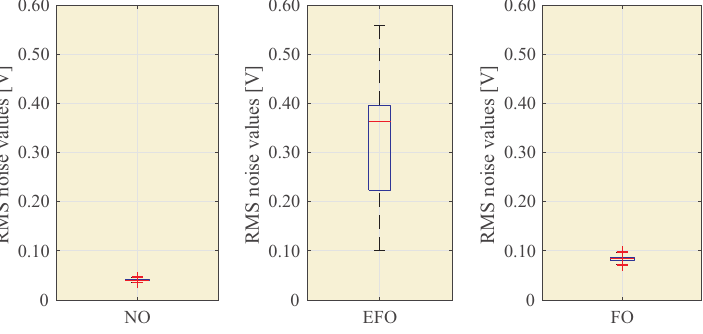
Figure 14. Box plots of the RMS sound values for NO, EFO, and FO of the IVT. Step 4 : Perform real-time measurements to obtain instantaneous RMS values V RMS .